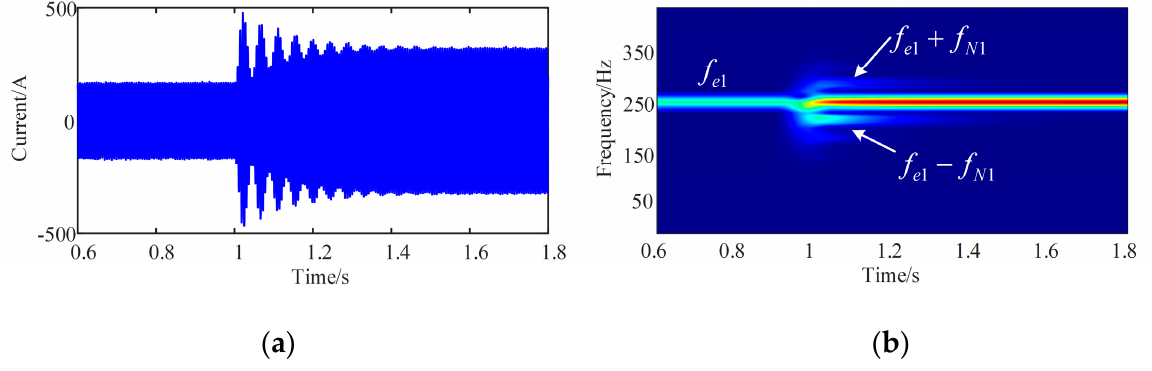
Figure 18. Motor 1 stator current: ( a ) time domain; ( b ) time-frequency domain (0-450 Hz). The PMSM and gear transmission system in the DEDS are directly connected by the motor shaft, so the stiffness and damping characteristics of the motor shaft directly determine the vibration response of the DEDS. To investigate the effect of different motor shaft stiffness damping values on the dynamic characteristics of the gear system